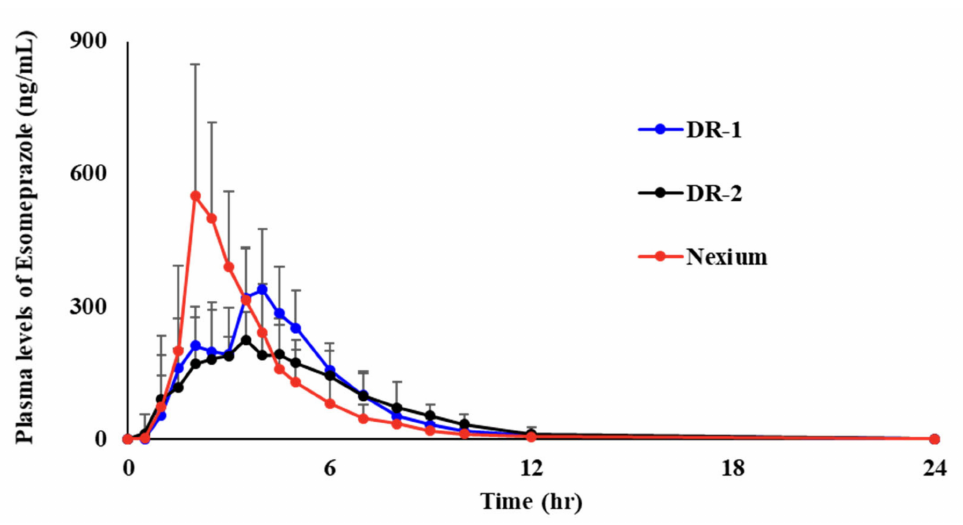
Figure 7. Mean plasma concentration of EMP versus time after a single administration of commercial product (Nexium ® ), DR-1, and DR-2 at the equivalent dose of 40 mg EMP. Table 6. The pharmacokinetic parameters of commercial product and DR polycap (DR-1 and DR-2) after single oral administration in beagle dogs (n =